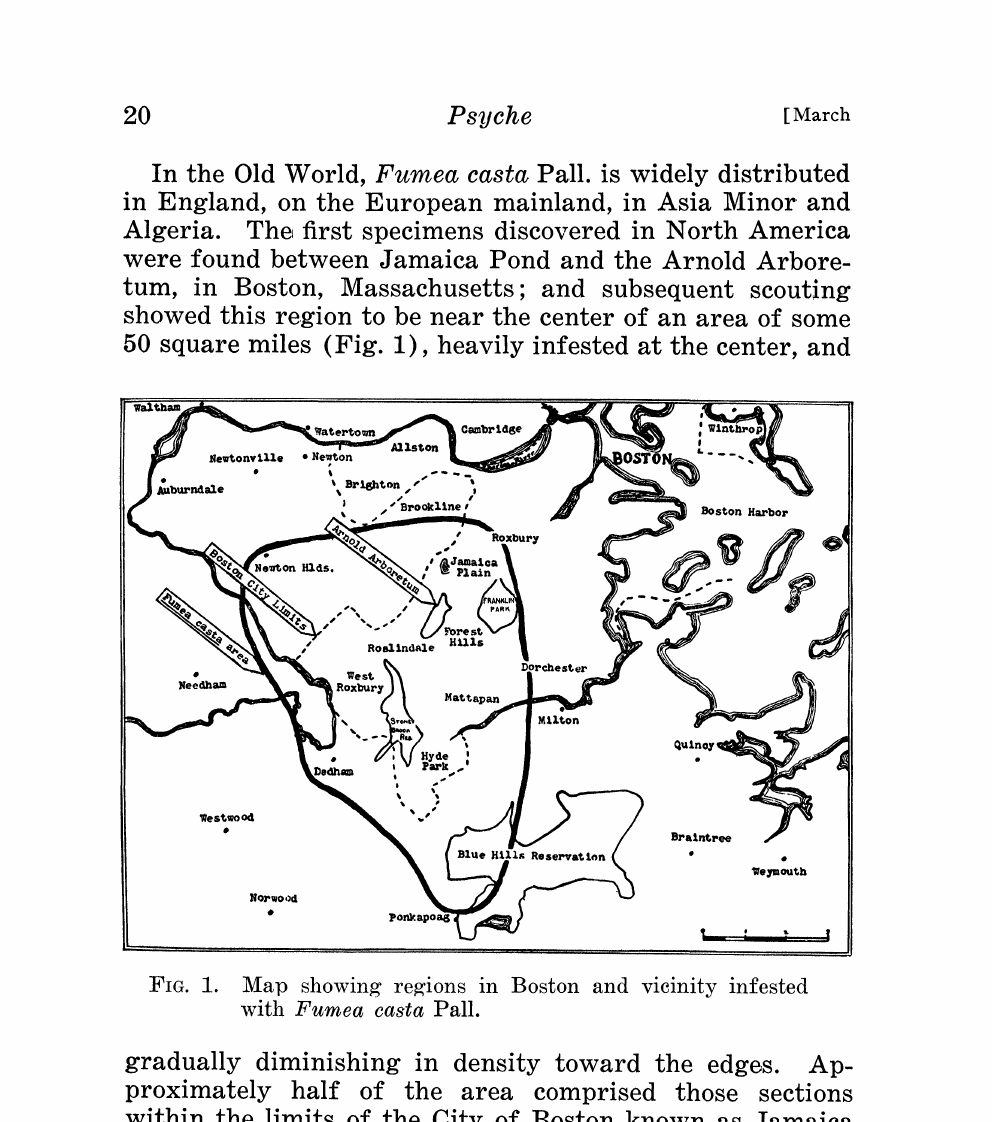
FIG. 1. Map showing regions in Boston and vicinity infested with Fumea casta Pall. gradually diminishing in density toward the edges.